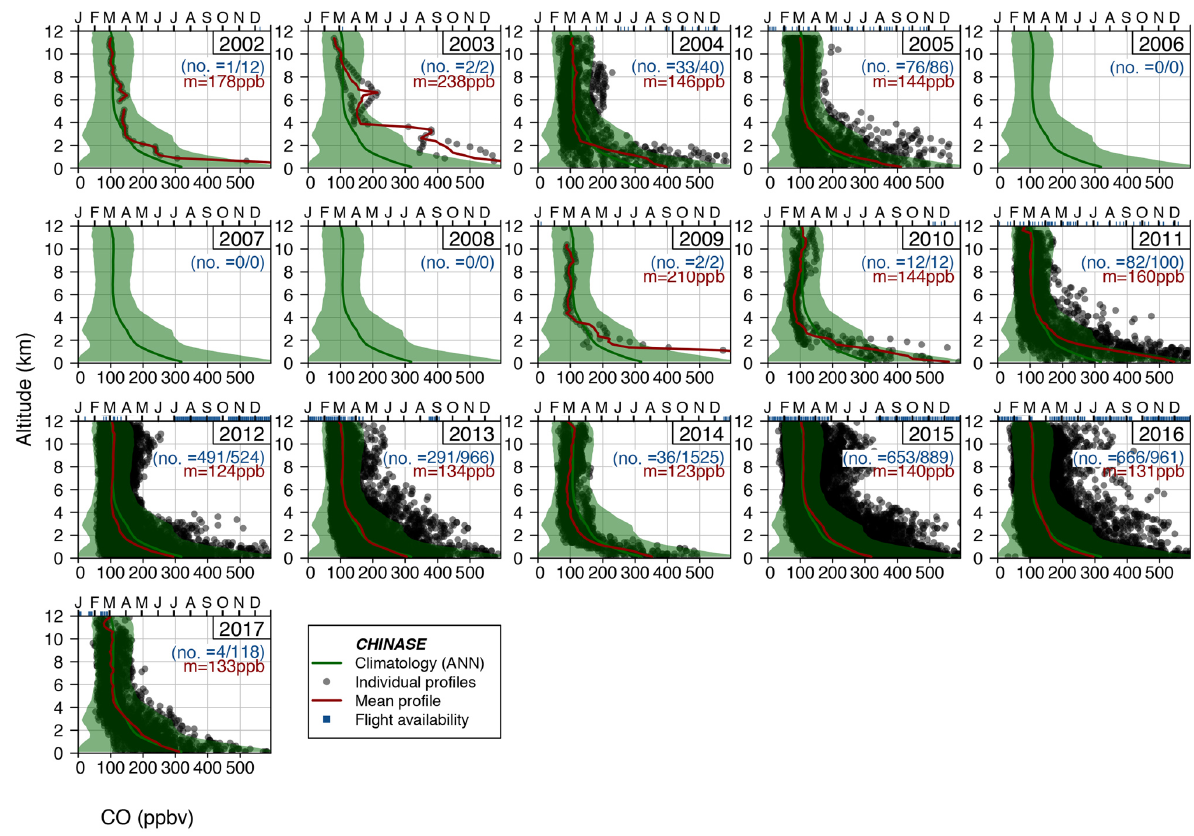
Figure 9. Same as Fig. 6 at the ChinaSE